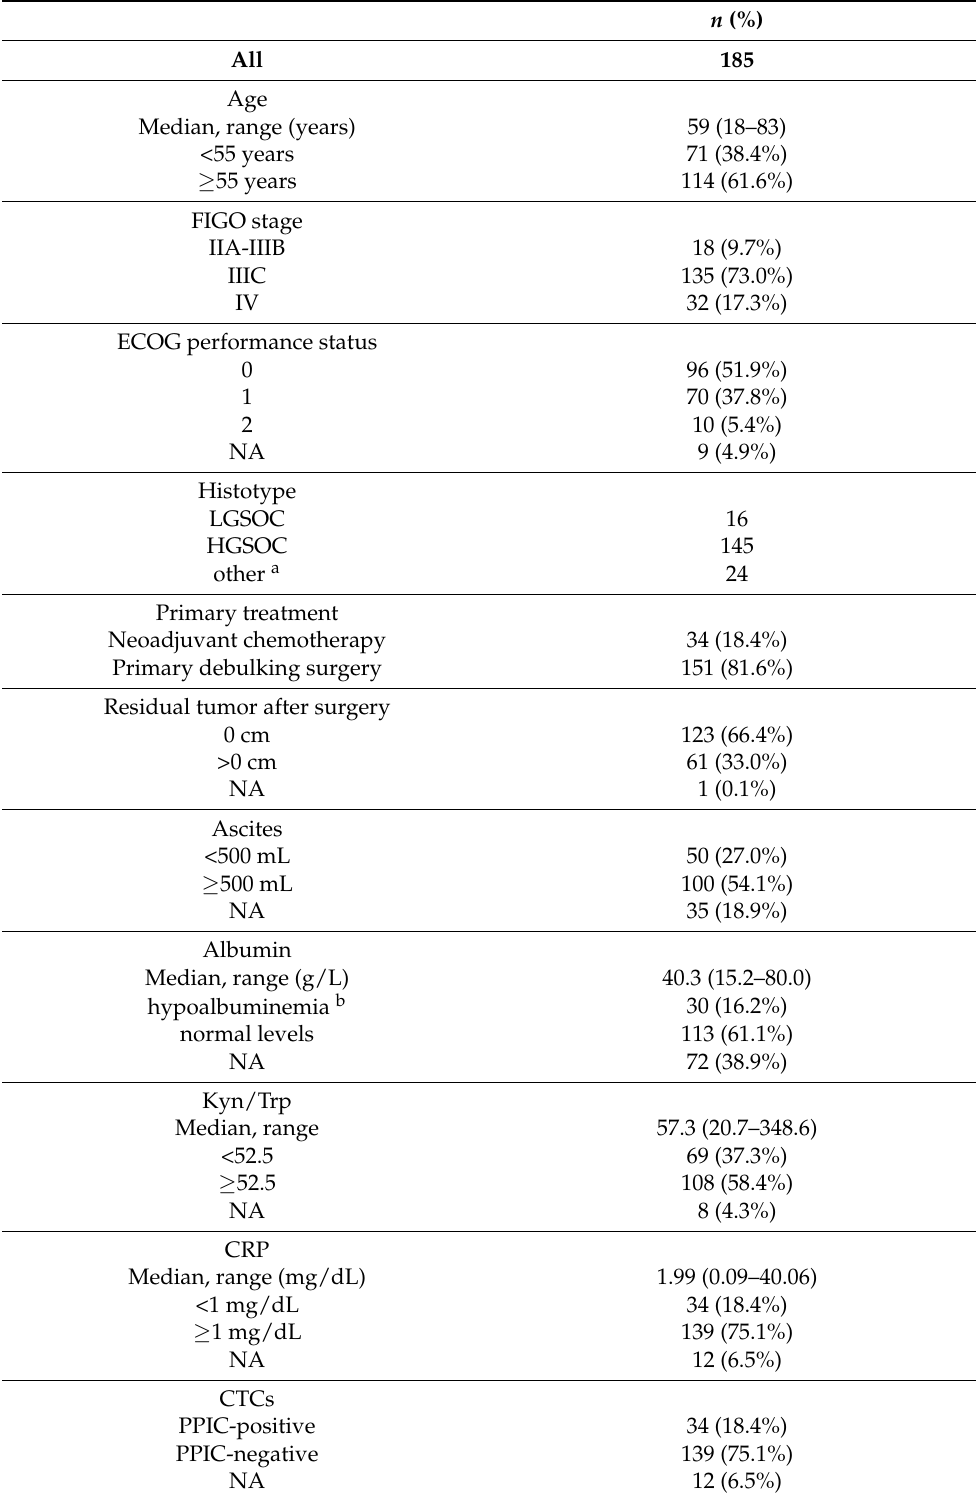
Table 1. Baseline characteristic of the patients. LGSOC, low grade serous ovarian cancer; HGSOC, high grade serous ovarian cancer; a clear cell ( n = 2), endometrioid ( n = 7), mixed epithelial ( n = 7), undifferentiated ( n = 8); b plasma albumin ≤ 35.0 g/L. NA not